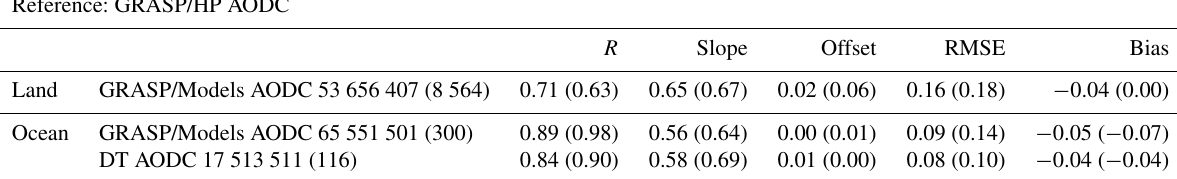
Table 21. The same as Table 20, but for